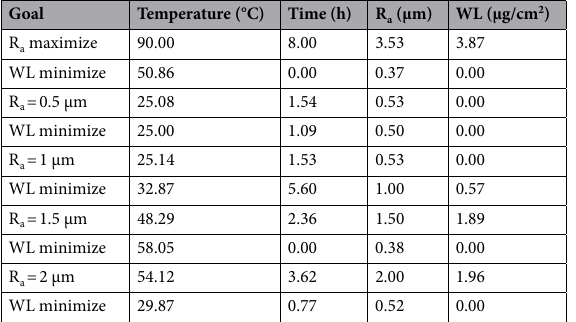
Table 2. Some optimized points with infinite C.D. for R a –WL